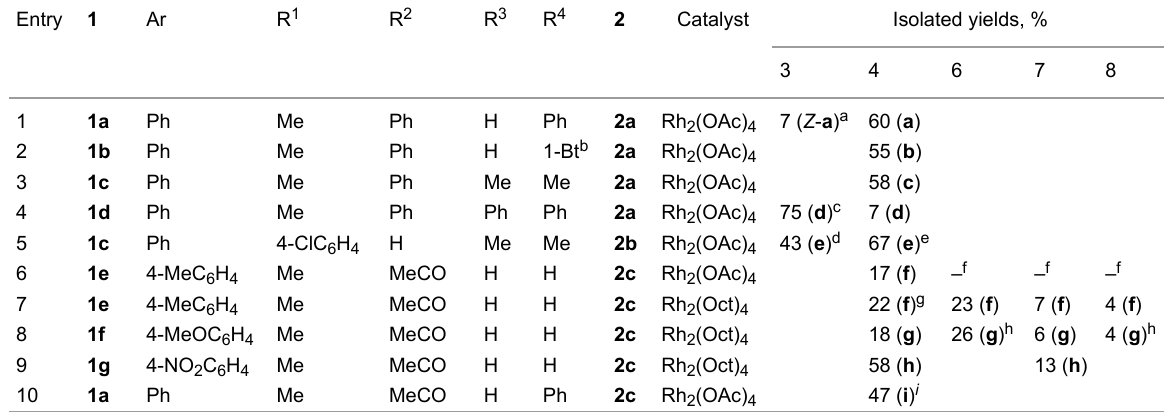
Table 1: Rh(II)-catalyzed reaction of azirines 1a – g with diazo compounds 2a – c (method A, DCE, 84 °C). Entry 1 Catalyst Isolated yields,